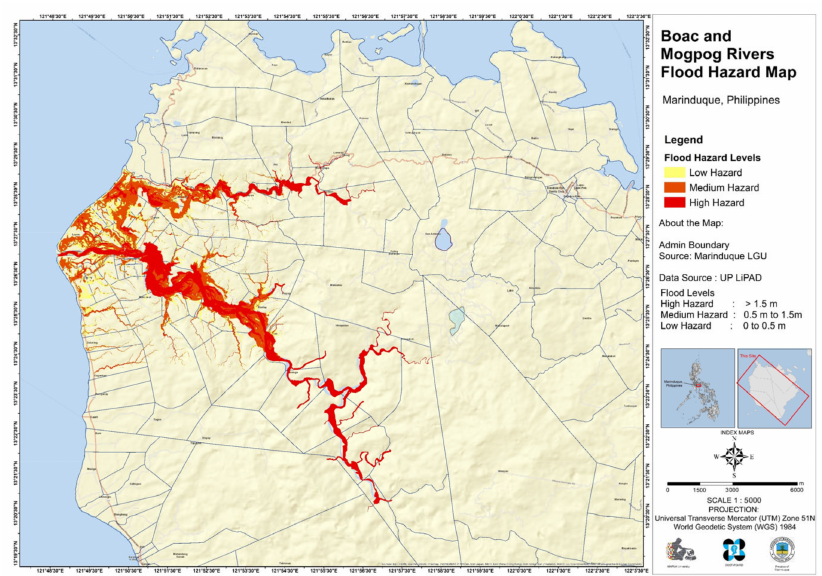
Figure 4. The flood hazard map of Boac and Mogpog rivers using LiDAR